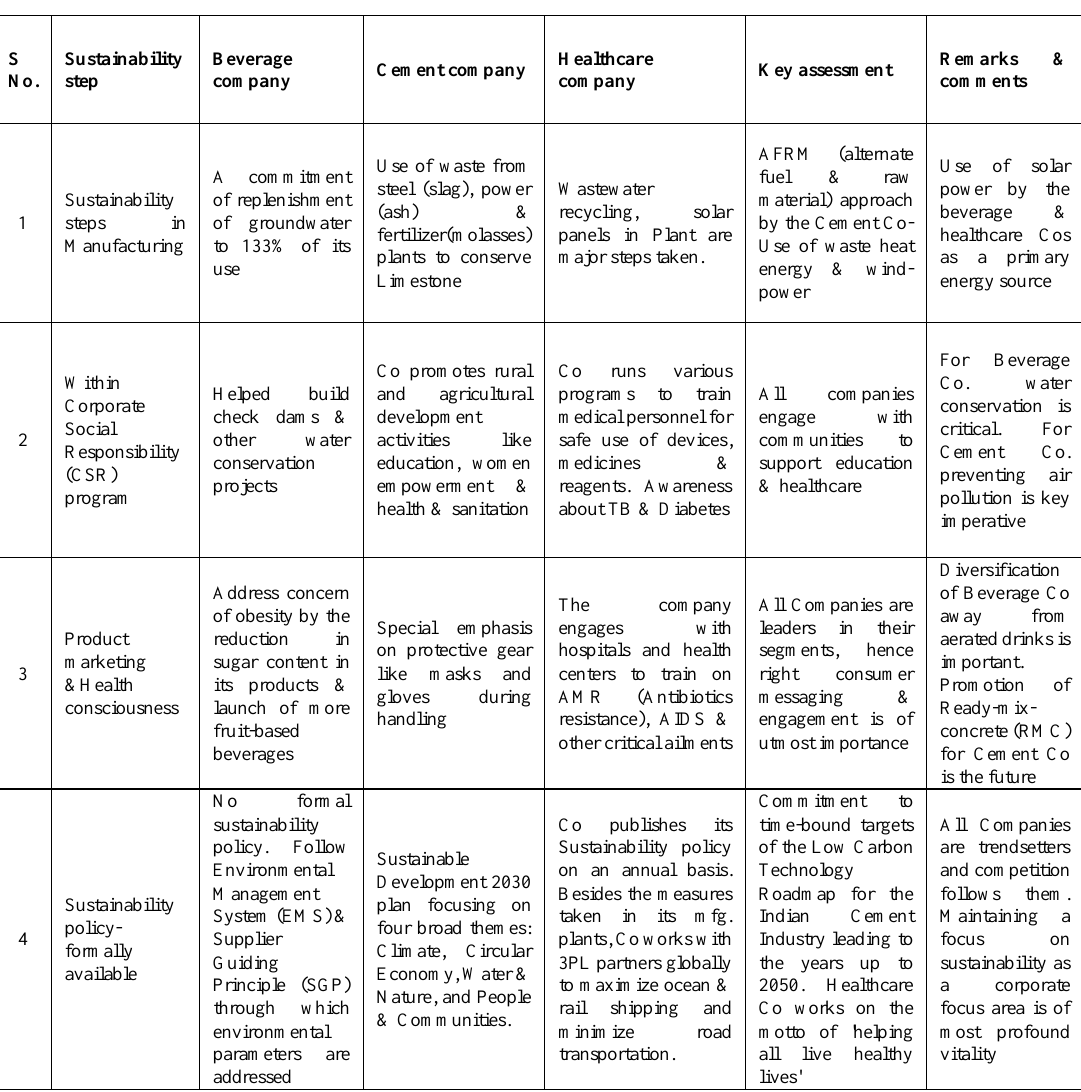
Table 4. Sustainability steps in